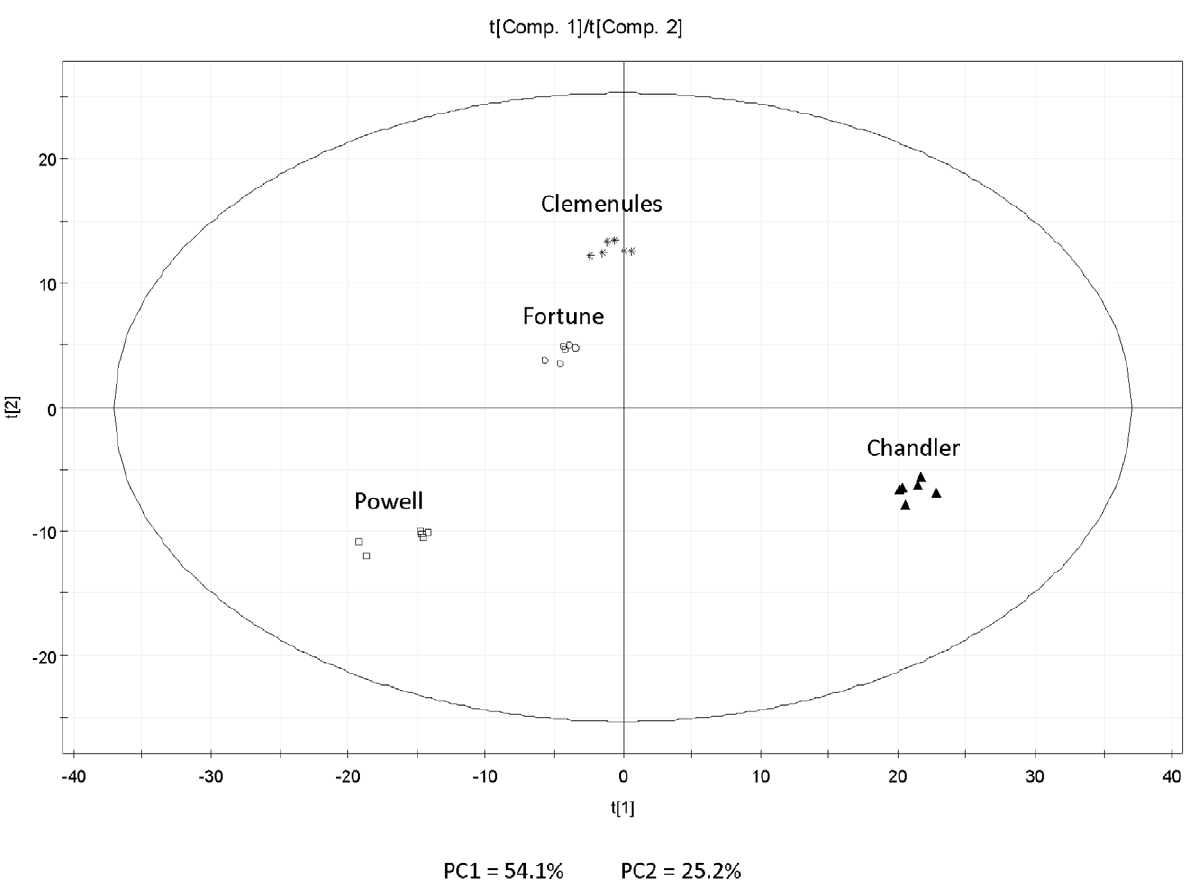
Figure 1. Principal Component Analysis score plot (t[1] vs t[2]) for the first and second principal components.